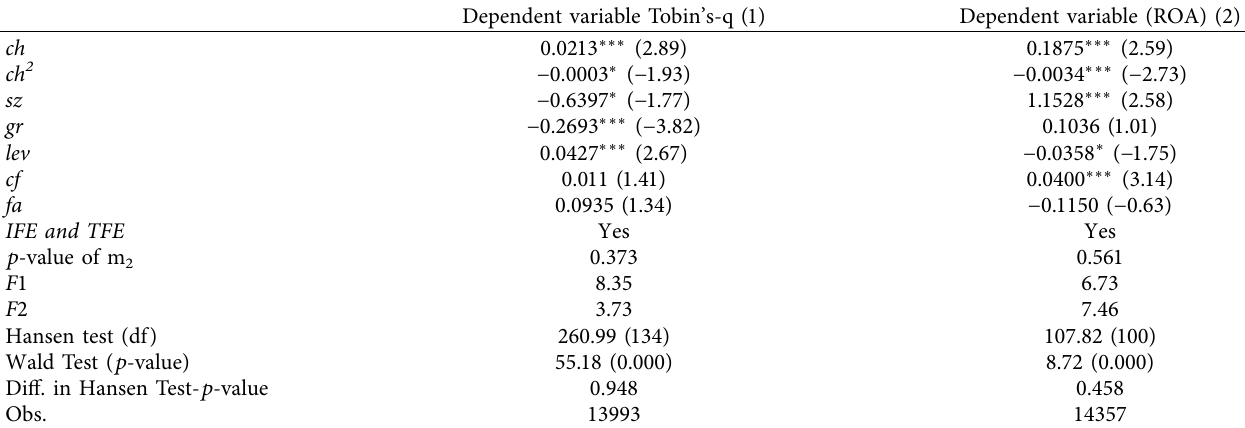
Table 3: Regression results for functional form estimation for cash holding and corporate